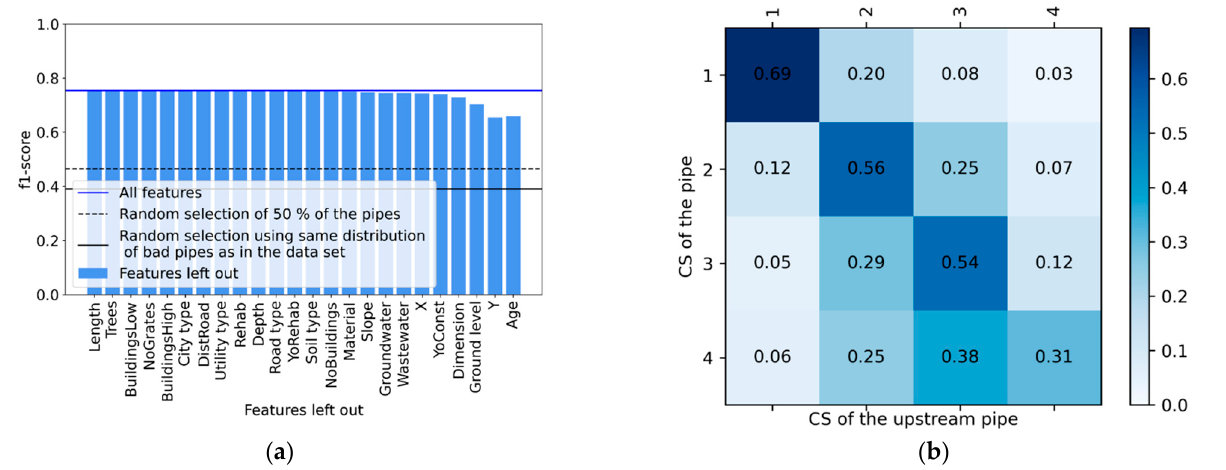
Figure 2. ( a ) Backward feature step analysis for the baseline. Each chart shows the performance before the least contributing feature remaining has been removed, starting from the left to the right. The dashed and solid lines shows the performance if utilizing a random selection of respectively 50% of the pipes and a percentage corresponding to the distribution of bad pipes in the dataset. ( b ) Normalized confusion matrix for a pipe and the upstream connected pipe.